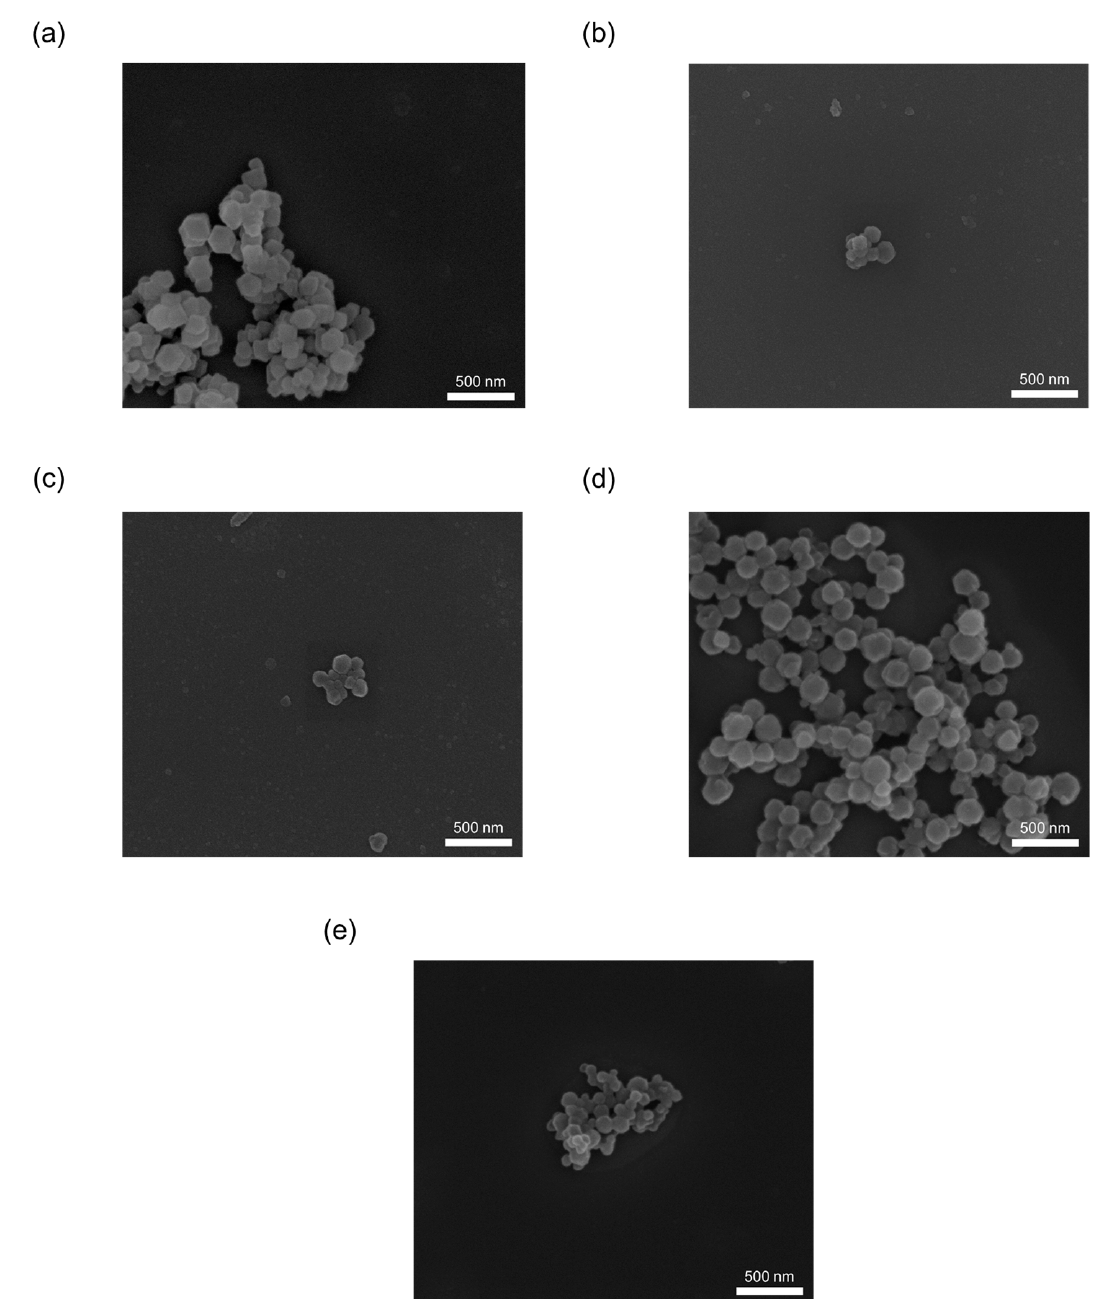
Figure 4. The SEM images of ZIF-8 samples with de novo- synthesis and impregnation methods using AgNO 3 as the precursor. ( a ) ZIF-8, ( b ) 04AgNO@ZIF (de novo), ( c ) 08AgNO@ZIF (de novo), ( d ) 01AgNO/ZIF (impregnation), ( e ) 02AgNO/ZIF (impregnation).